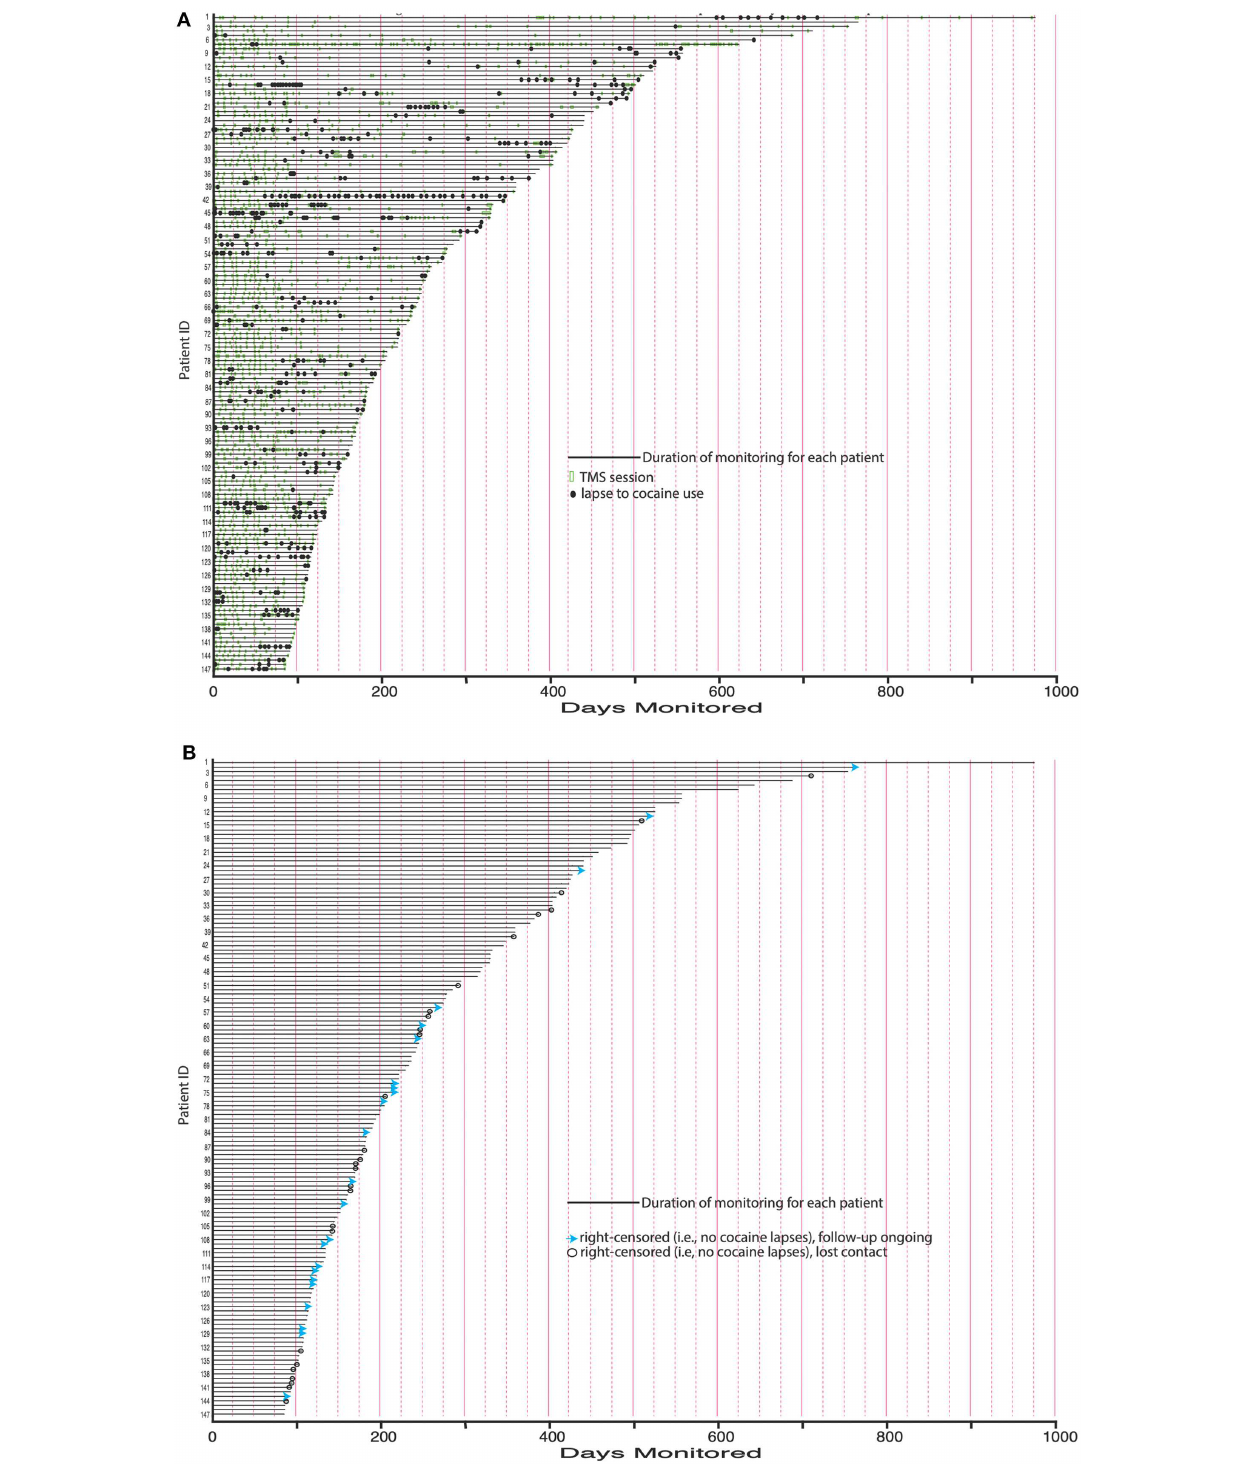
FIGURE 2 | (A) Maintenance rTMS sessions and time between lapses for closely followed subsample. Green rectangles: Maintenance rTMS sessions after the initial 8-day course of rTMS. For most patients, rTMS was readministered weekly, then monthly. This was done in response to lapses and in anticipation of lapses. Black circles: Lapses to cocaine use. Lapses tended to occur approximately every month for most patients, but with long stretches of abstinence separating them. (B) Causes of censoring in closely followed subsample. Blue arrows: Continuously abstinent patients for whom follow-up is ongoing. Open black circles: Continuously abstinent patients who were lost to further